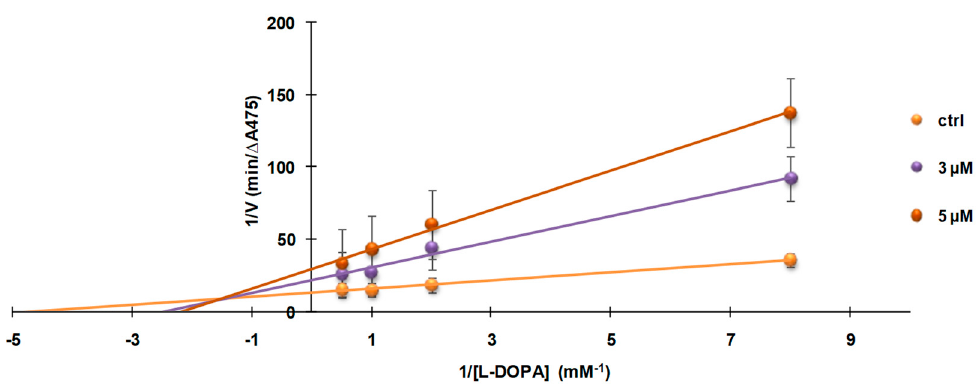
Figure 6. Lineweaver–Burk plot for the inhibition of mushroom tyrosinase ‐ catalyzed L ‐ DOPA oxidation by LC at 0 (control (ctrl)), 3 or 5 μ M. Data were obtained as mean ± SD values of 1/V, inverse of the increase of absorbance at 475 nm per min ( Δ A 475 /min), of three independent experiments with different concentrations of L ‐ DOPA.